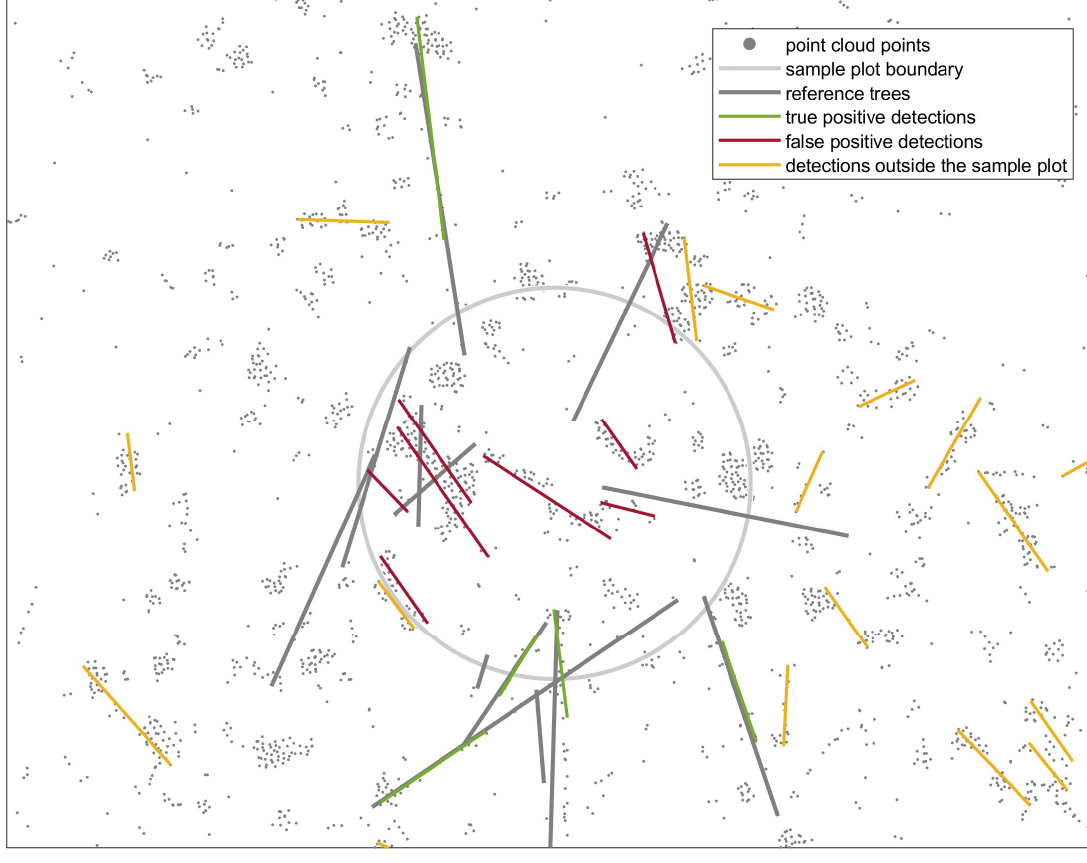
Figure 3. Validation on a single sample plot. The figure shows an example of reference trees and line segments detected by the fallen tree detection method on a single sample plot. Note that detection was performed on a buffered point cloud extending beyond the sample plot boundaries. This ensured that reference trees falling partially outside the sample plot could be detected. Using a buffered point cloud resulted in detections that could not be matched with a reference tree and that were located fully outside the sample plot boundaries. These detections (yellow lines in the figure) were discarded. Green lines depict detections that could be matched with a reference tree (true positives). In contrast, red lines depict detections that could not be matched with a reference tree and that were at least partially located within the sample plot (false